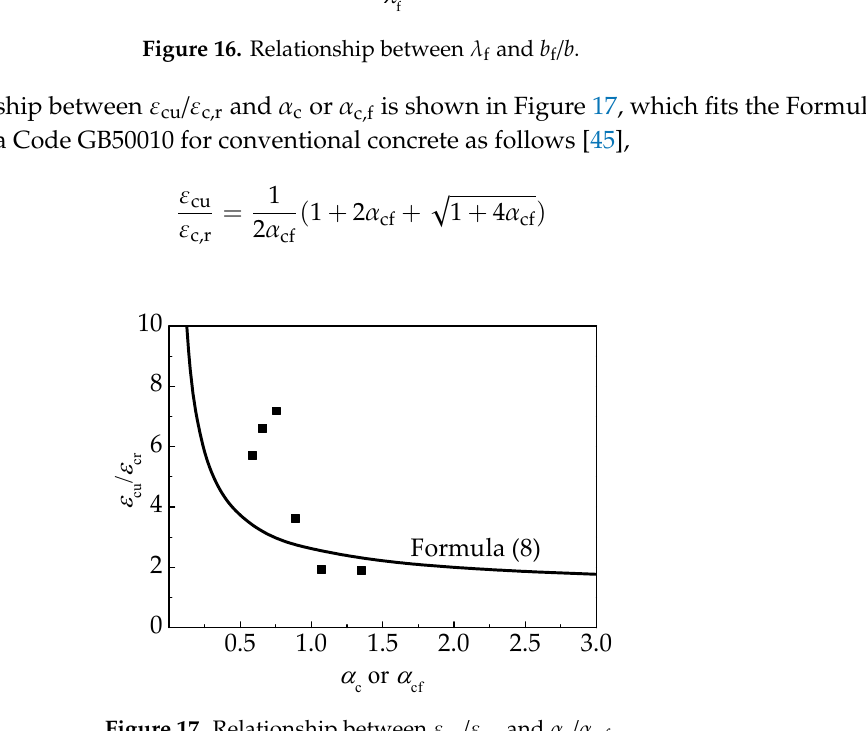
Figure 16. Relationship between λ f and b f / b.